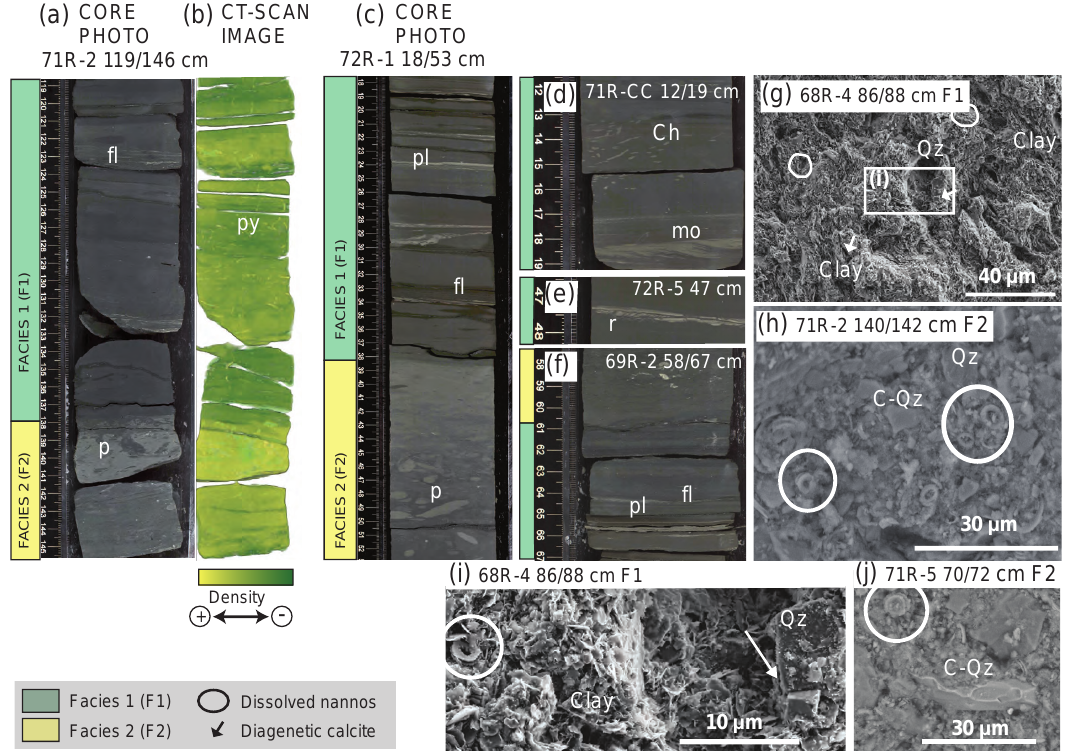
Figure 3. Detailed images, CT scans, and HR-SEM from Facies 1 (F1) and Facies 2 (F2). (a) Example of F1 taken from Core 71R-2 119/146cm, showing faint laminations (fl) and bioturbation by Planolites (p). (b) CT-scan 3-D image of the same core interval; note the pyritized burrows (py). (c) Example of F2 taken from core 72R-1 18/53cm). (d–f) Close-ups of laminations from F1: ripples (r), planar lamination (pl), and faint laminations (fl), with mud offshoots (mo). (d) Chondrites (Ch) bioturbation inside F1. (g) HR-SEM image of F1 (68R-4-86/88cm) with detritic aspect and a mudstone clay matrix, quartz grains (Qz), diagenetic calcite (arrows), and dissolved coccoliths (circles). (h) HR-SEM image of F2 (71R-2 140/142cm) silt-sized matrix and reworked calcareous nannofossils and conchoidal quartz grain (C-Qz). (i) Detail of dissolved coccoliths and diagenetic calcite mineral. (j) Detail of a dissolved and reworked calcareous nannofossils and a fractured conchoidal quartz